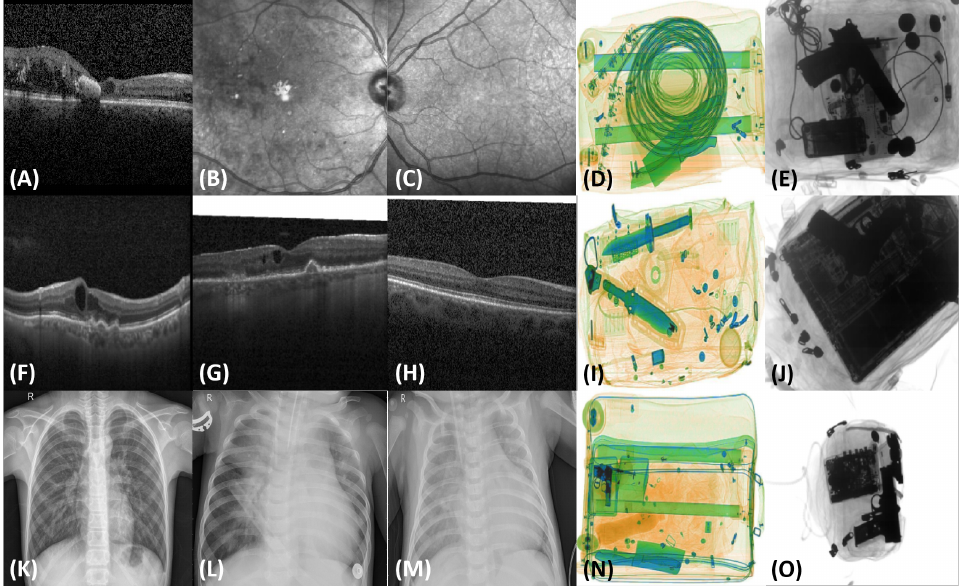
Figure 1. Example images showcasing different classification tasks. ( A , F – H ) show retinal OCT images of DME, wet AMD, dry AMD, and a healthy subject, respectively. ( B , C ) show retinal fundus scans of DME and a healthy subject, respectively. ( K – M ) show chest X-ray scans of pneumonic patents, and the rest of the scans showcase the examples of suspicious items in colored ( D , I , N ) and grayscale ( E , J , O ) X-ray